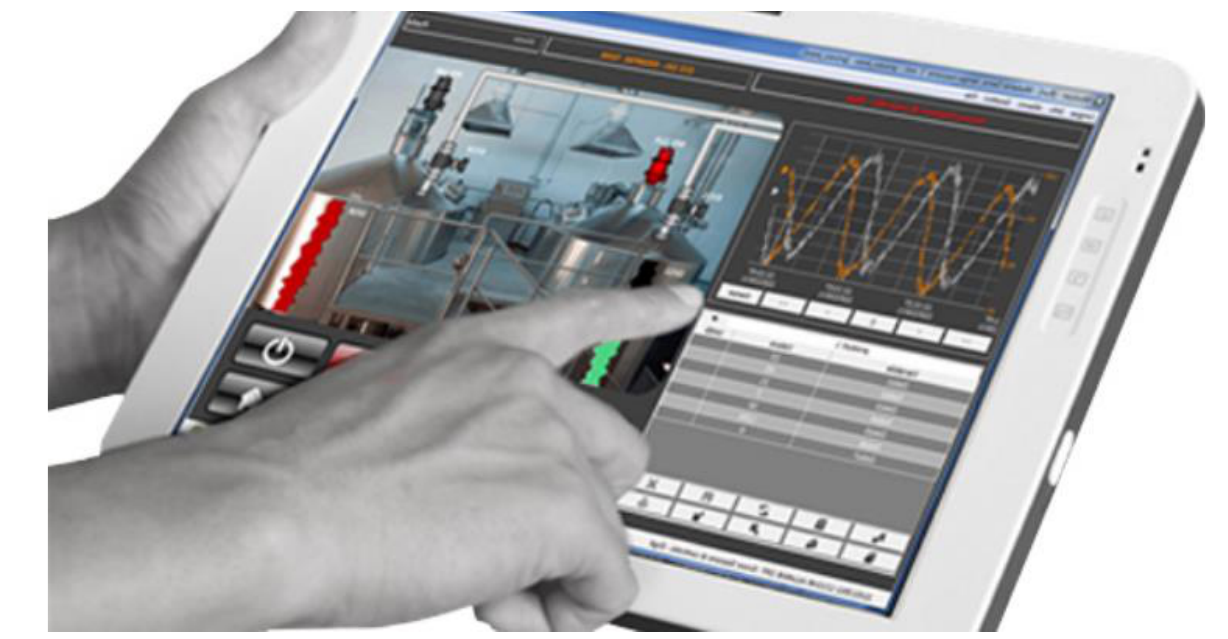
Figure 2. Movicon’s CE Overview [16].